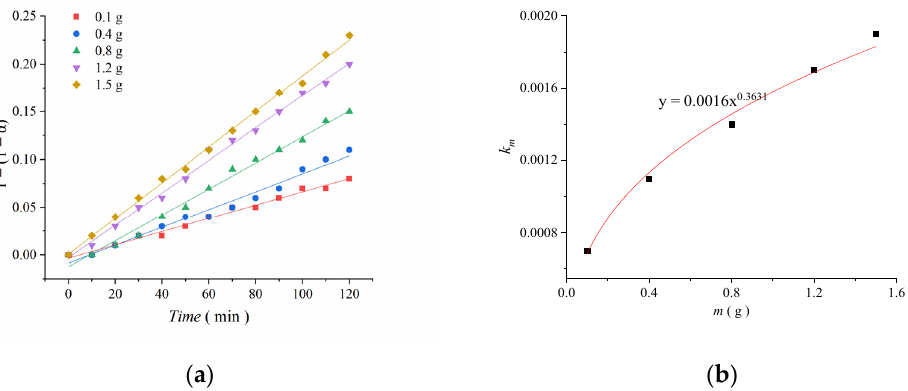
Figure 5. ( a ) Curve of 1 − (1 − α ) 1/3 with time under different FeS 2 masses. ( b ) Fitting curve of k m and m.